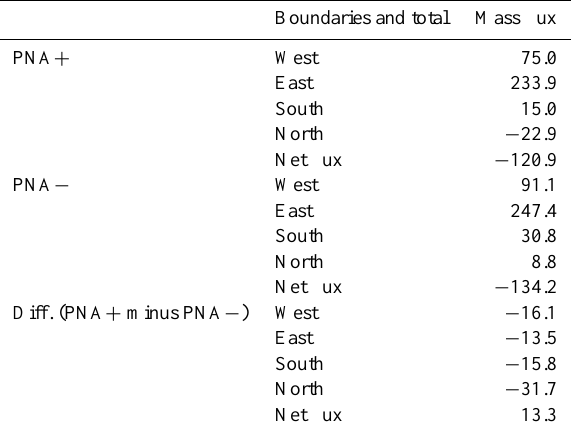
Table 3. The composite analyses of horizontal mass fluxes (kgs − 1 ) of PM 2 . 5 for the selected box of (75–120 ◦ W, 28–49 ◦ N; from the surface to 250hPa) in the PNA + and PNA − months of 1986– 2006. The positive values at the four boundaries indicate eastward or northward transport, and negative values indicate westward or southward transport. The positive (negative) value of net flux indi- cates the net gain (loss) of PM 2 . 5 in the selected box. All the fluxes are from the GEOS-Chem simulation. Boundaries and